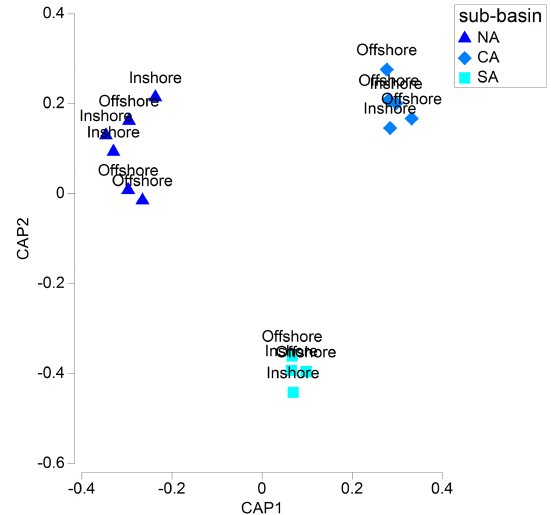
Figure 3. CAP plot of the mesozooplanktonic communities of the Adriatic basin by sub-area and inshore vs. offshore location, based on abundance data. Colours indicate the sub-basins, as described in the